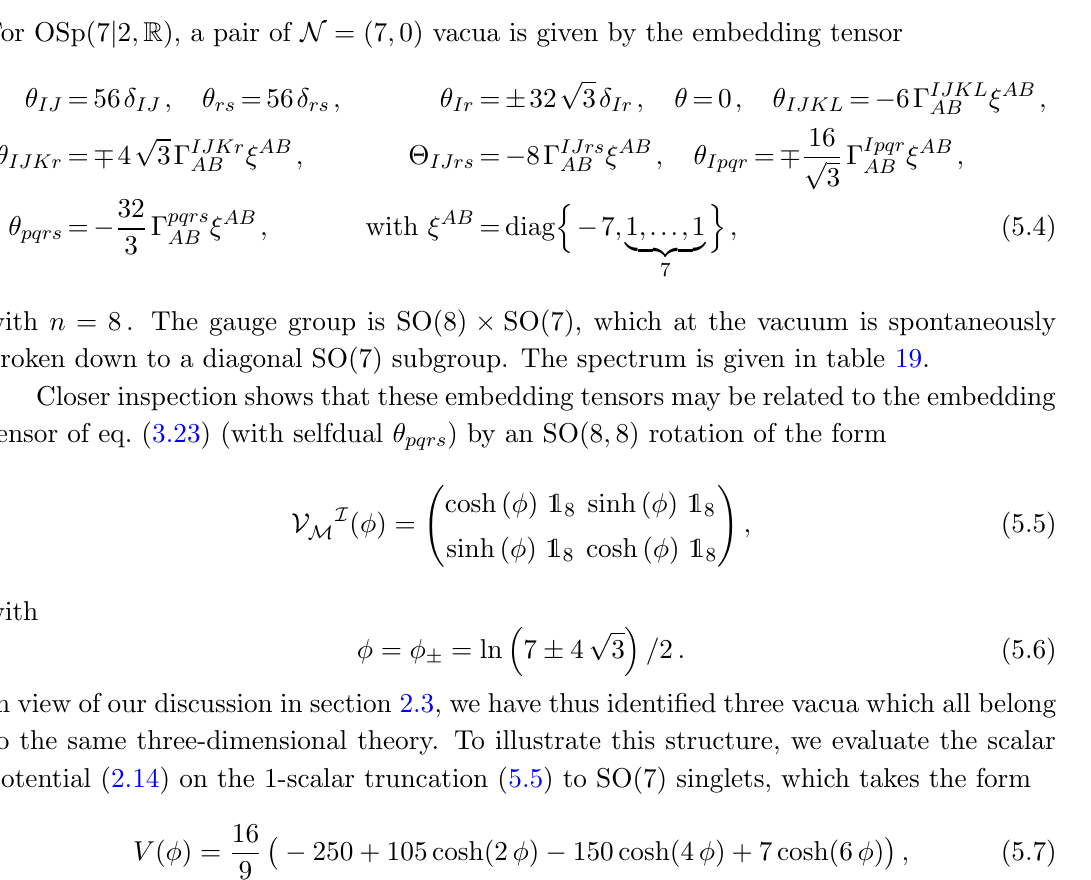
Table 19. Mass spectrum for the OSp(7 gauge group is SO(8)